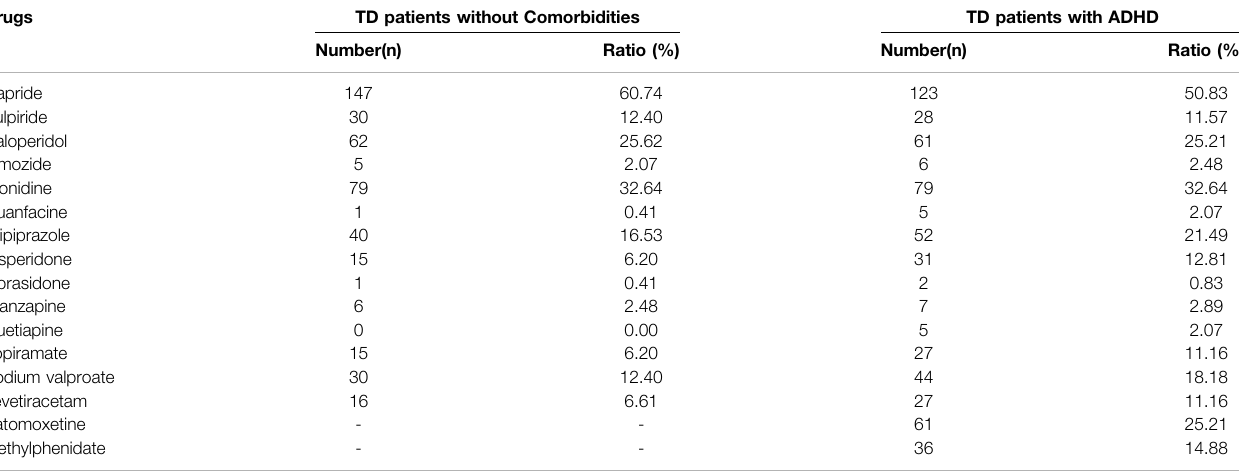
TABLE 3 | Preferred drugs during treatment (N = 242). Drugs TD patients without Comorbidities